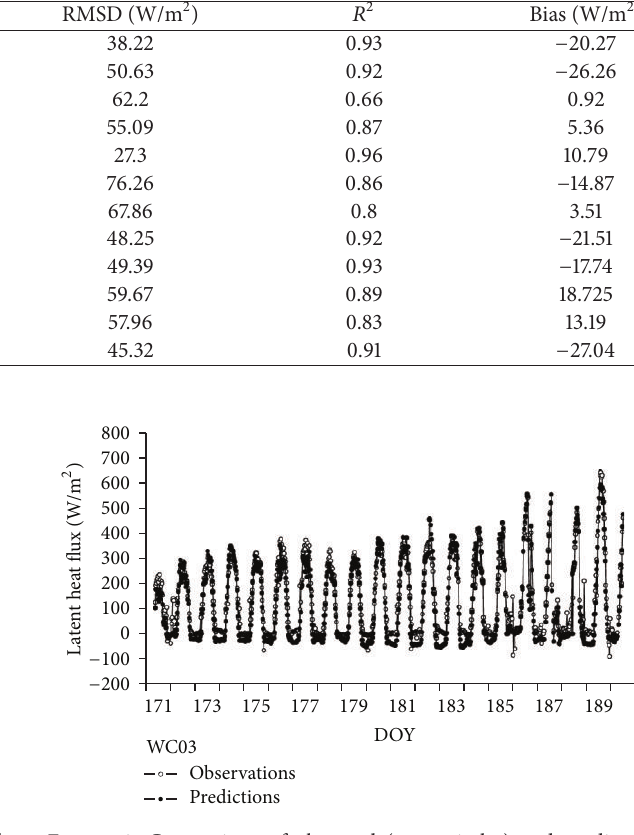
Figure 3: Comparison of observed (open circles) and predicted (solid dots) latent heat flux (W/m 2 ) for WC03. (The gap in the figure was due to lack of observations. DOY means the day number of the year in